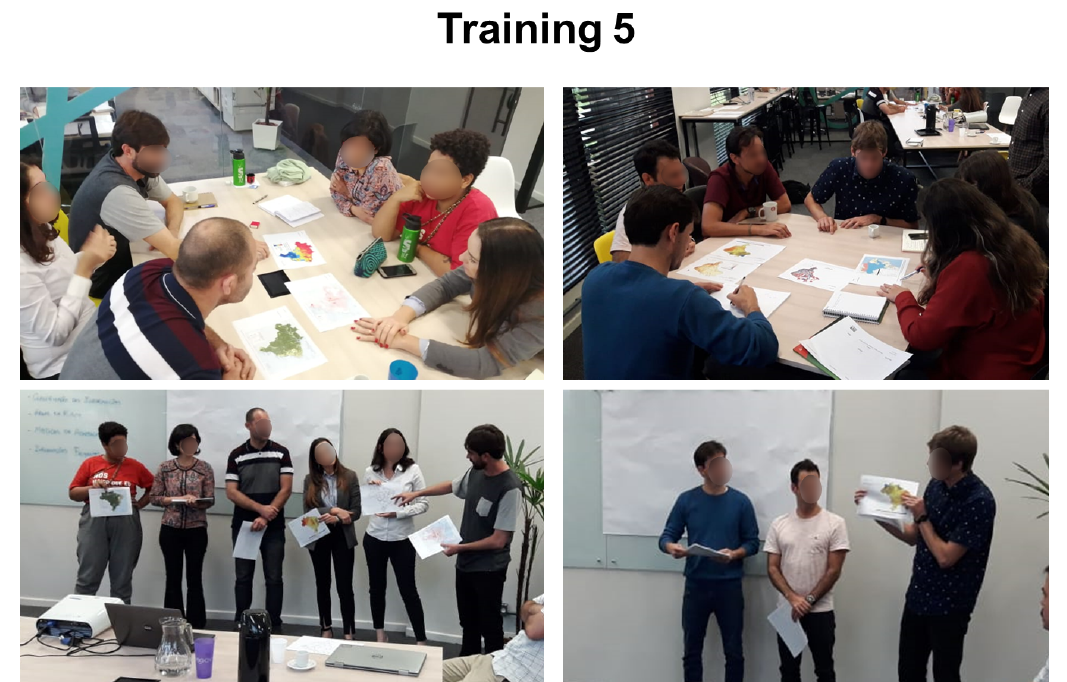
Figure A24. Photos of the groups working on the activities of the fifth